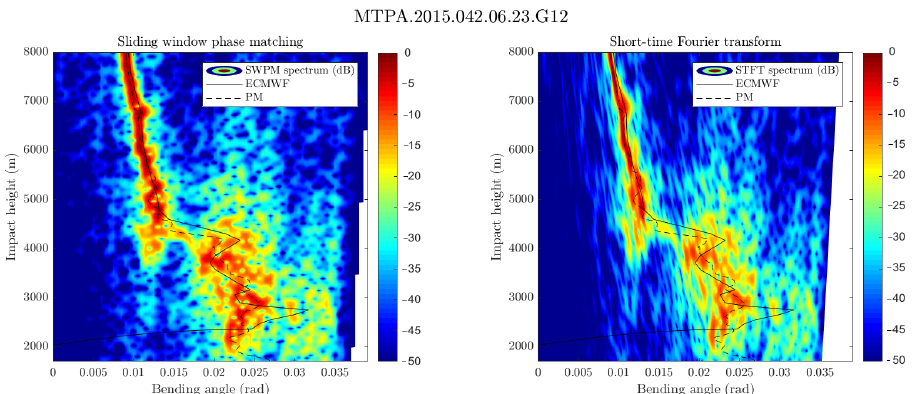
Figure 12. A MetOp-A occultation from UTC 0623 2015-02-10, 22.28 ◦ N, 73.64 ◦ E. Left shows SWPM, right shows STFT. ECMWF BA is shown in solid black, standard PM is shown in dashed black. The window length for STFT is 2.0